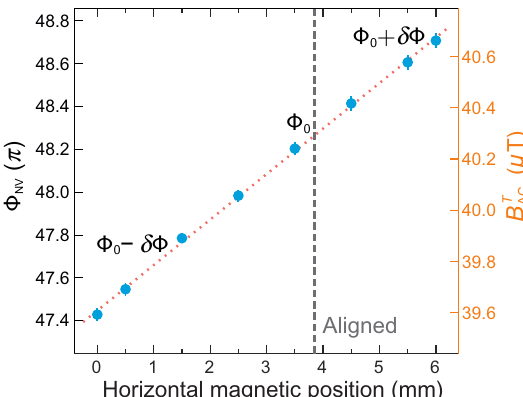
FIG. 14. Linear dependence of the measured maximum pre- cession angle (cid:16) NV on B NV ⊥ , introduced by deliberately trans- lating our magnet in the horizontal direction about the optimal alignment at approximately 3.8